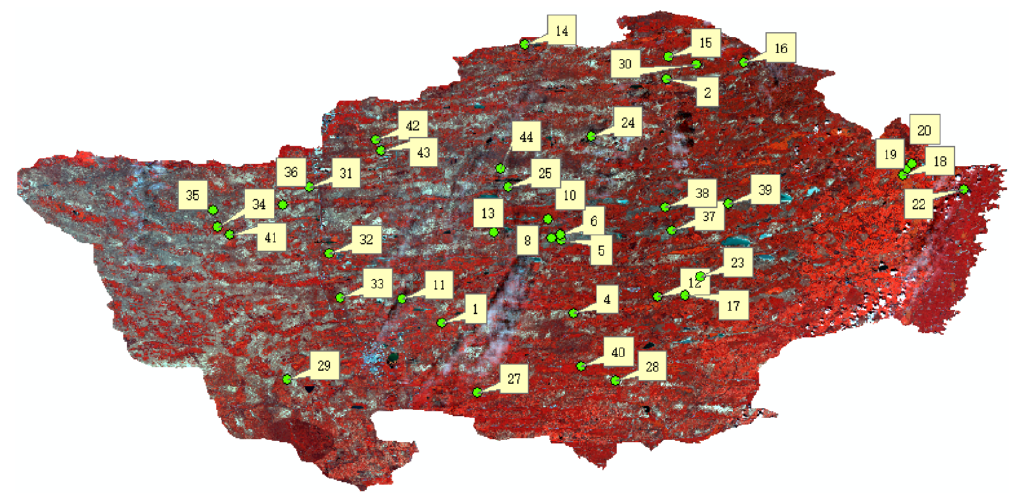
Figure 2. Site survey distribution point map in Horqin Left Wing Rear Banner.